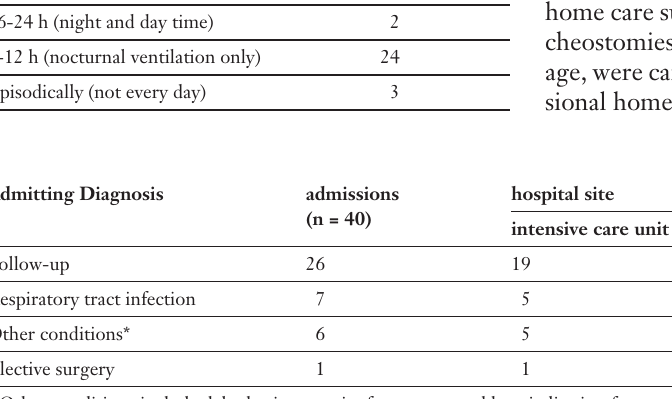
Table 4 Hours of daily venti- latory requirement of children supported by long-term ventila- tion in Switzerland.